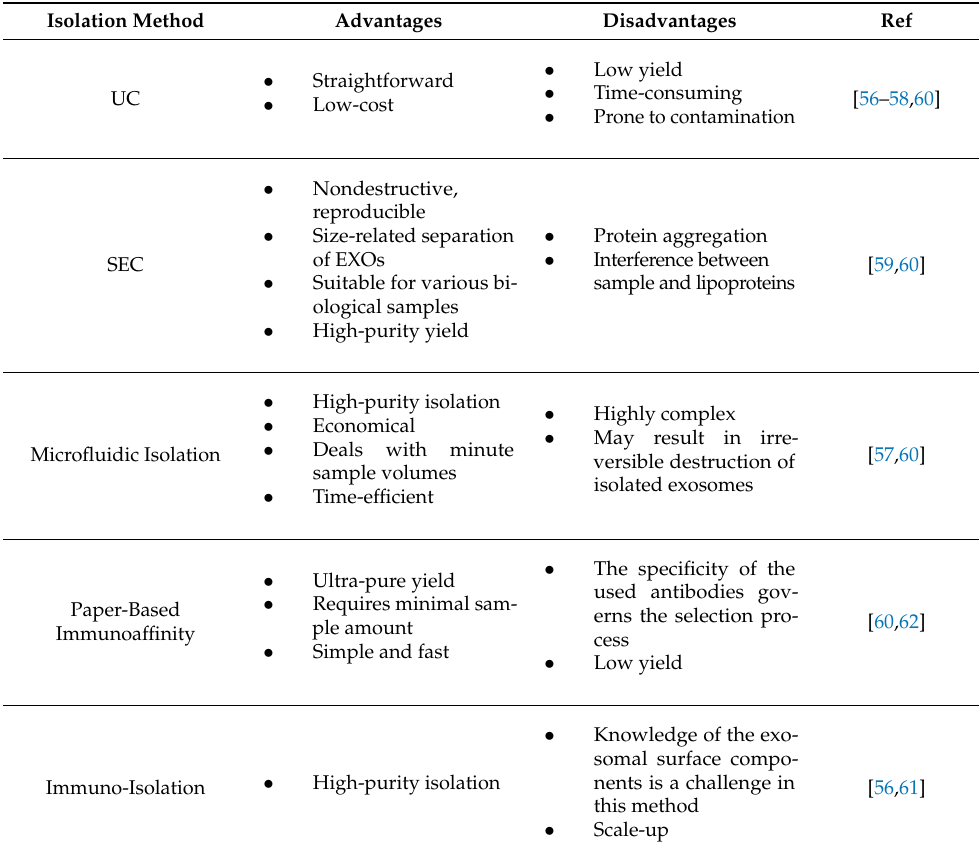
Table 1. Advantages and disadvantages of different isolation methods for